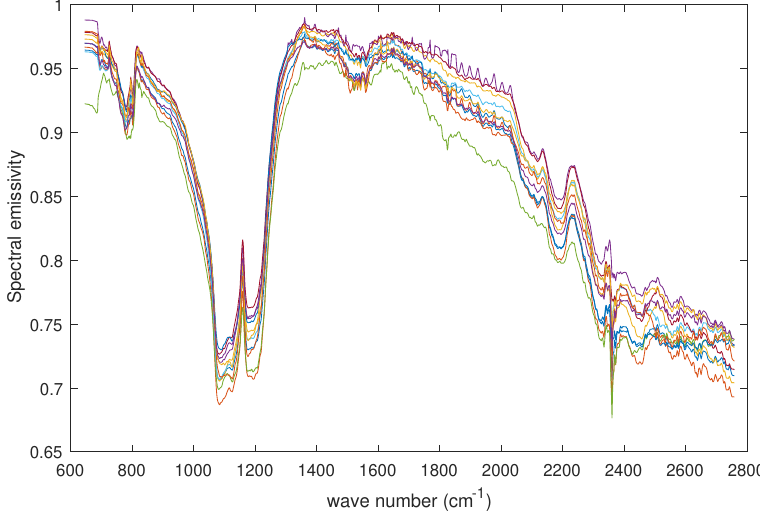
Figure 13. Retrieval of emissivity from IASI soundings over desert